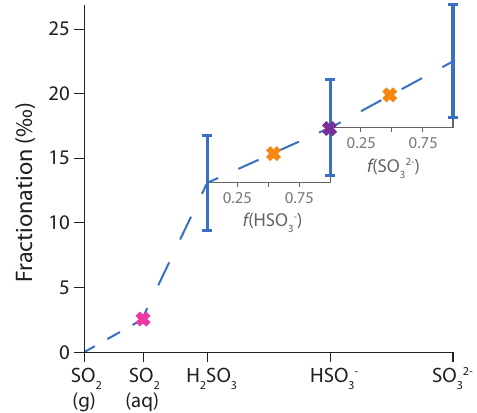
Fig. 3. Fractionation of 34 S/ 32 S at the different stages of SO 2 (g) → SO 2 − (aq) expressed as ((α 34 − 1 ) × 1000 ) . The blue line and error 3 bars show the cumulative change in δ 34 S as the reactions proceed. The crosses show measurements: yellow crosses are results from this paper, the pink cross is from Chmielewski et al. (2002) and the purple cross is from Egiazarov et al. (1971). All values are shown for 18–19 ◦